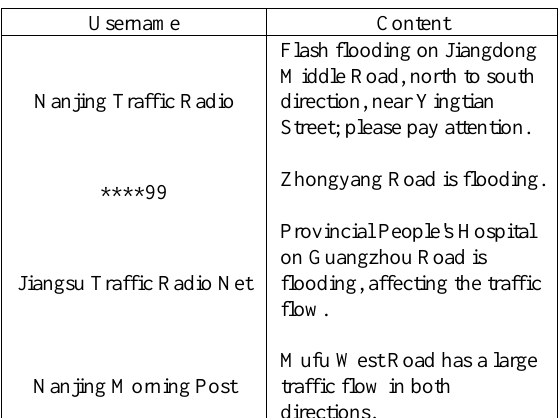
keywords for searching, and the dates of rainfall are used as time ranges for collecting relevant data. 246 relevant data are collected, and the data details are shown in Table 4.